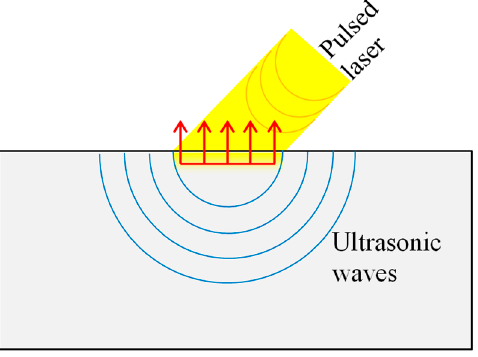
Figure 18. Principle laser ultrasonic.